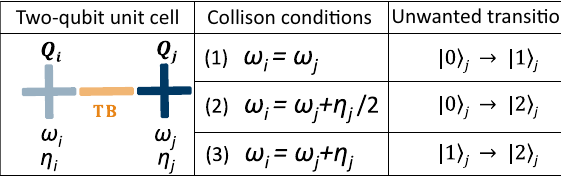
FIG. 3. Qubit frequency collision conditions and their associ- ated unwanted